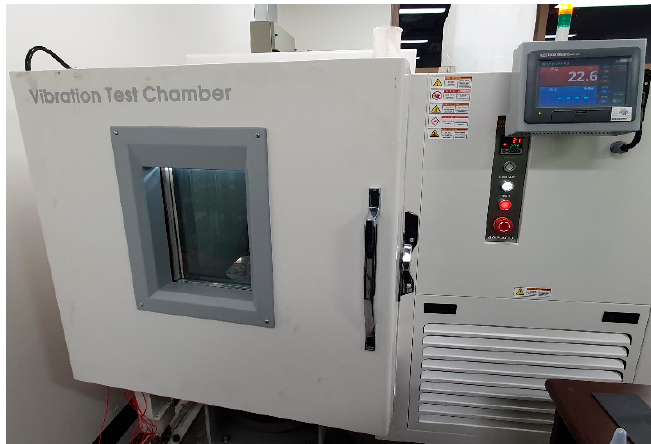
Figure 1. Configuration of the temperature chamber of the uniaxial exciter.